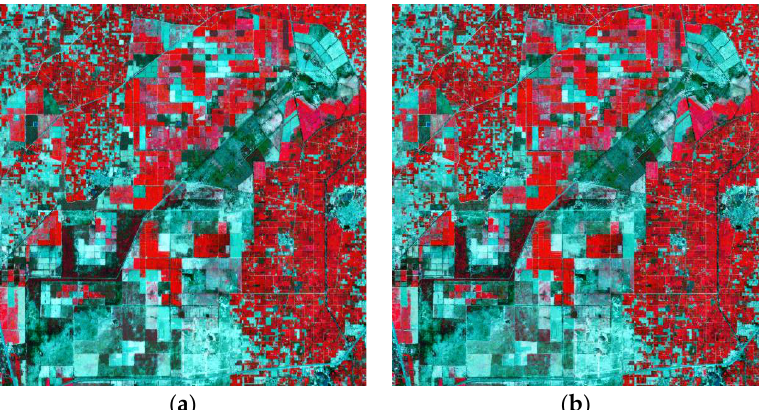
Figure 4. Sentinel 1A (S1) and Sentinel 2B (S2) fused images using proposed approach by ( a ) VH and ( b ) VV polarization.